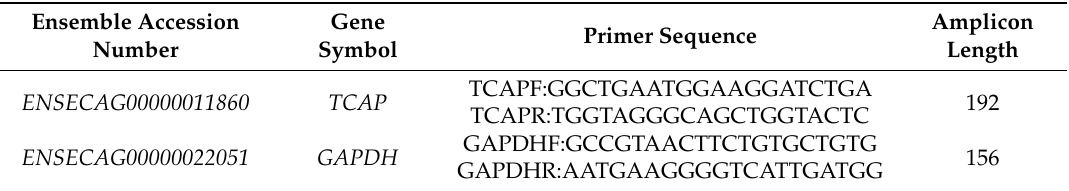
Table 1. Primer sequences for